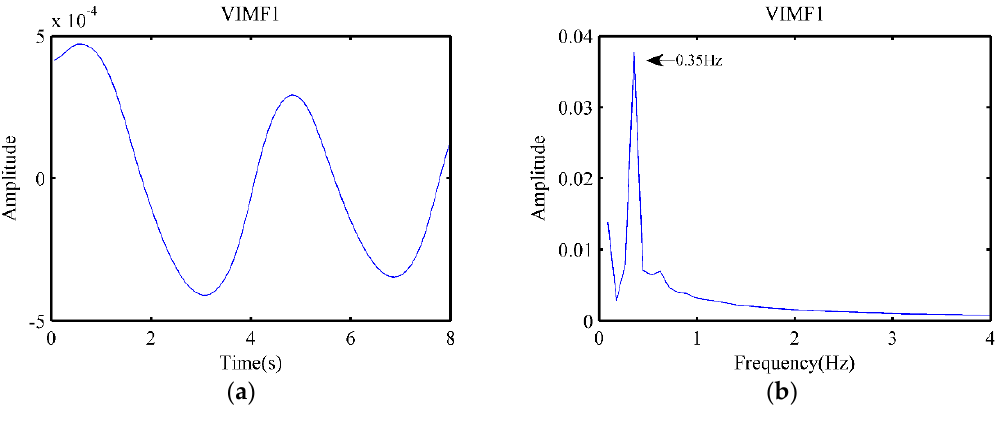
Figure 5. Experimental results. ( a ) The radar echo signal of the dog; ( b ) The spectrum of radar echo signal of the dog; ( c ) Breathing signal of the dog obtained by filtering; ( d ) Heartbeat signal received by radar and electrocardiogram (ECG), the inset shows waveform details at a selected 2-second duration.